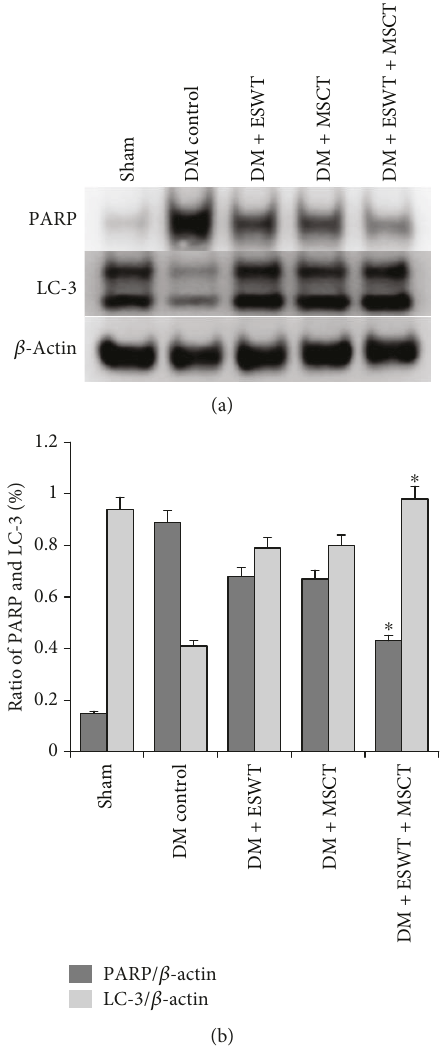
Figure 7: ESWT can activate autophagy and decrease apoptosis in vivo. (a) All groups were compared for PARP and LC-3 in vivo by Western blotting. (b) Quantity analysis of Western blotting, including PARP/ β -actin and LC-3/ β -actin. ∗ P < 0 01 compared with values from the DM control